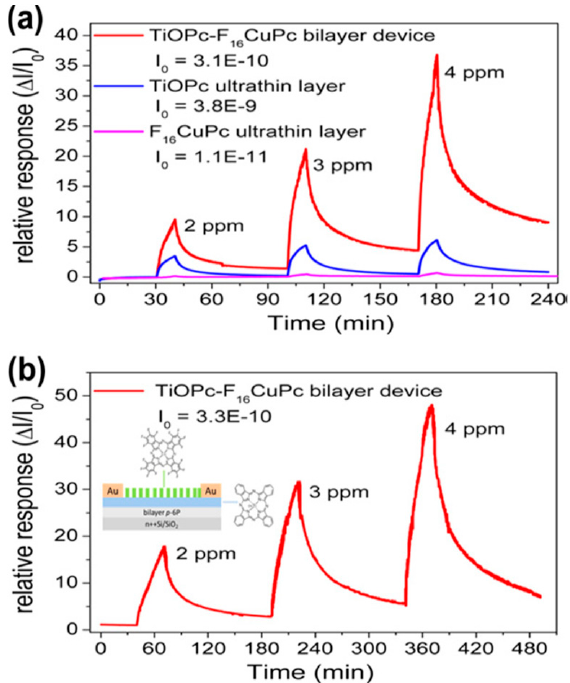
Figure 8. ( a ) Relative response of the three devices to NO 2 pulse as a function of time. The relative response is defined as normalized increase in device current. ( b ) The section view of bilayer device structure and the molecular structure of CuPcF 16 and TiOPc. Reprinted from [82] with permission from Elsevier.